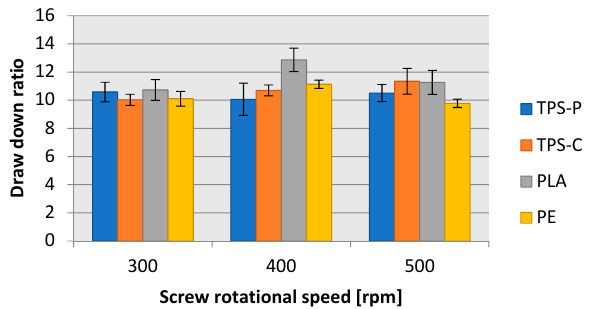
Figure 11. Relationship between the draw down ratio of the obtained film and the rotational speed of the extruder screw.